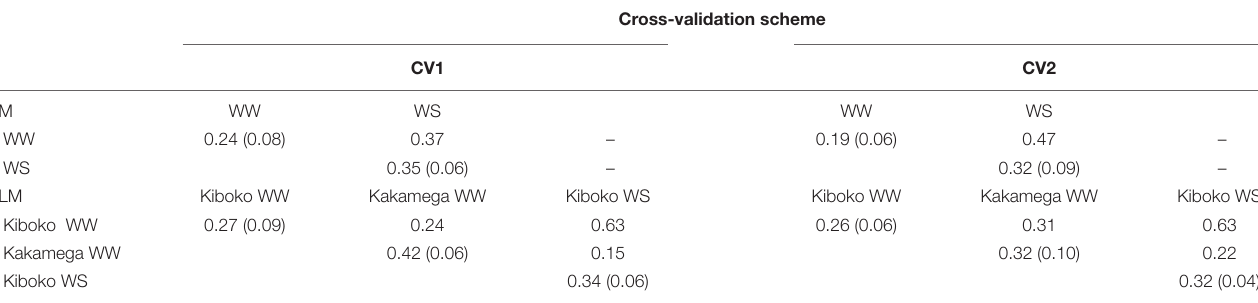
TABLE 2 | Plot level heritability (diagonal) and genetic correlations between pairs of managements or environments (upper diagonal) for the two managements (upper half) and three environments (lower half) from the factor analytic model analysis of 2017